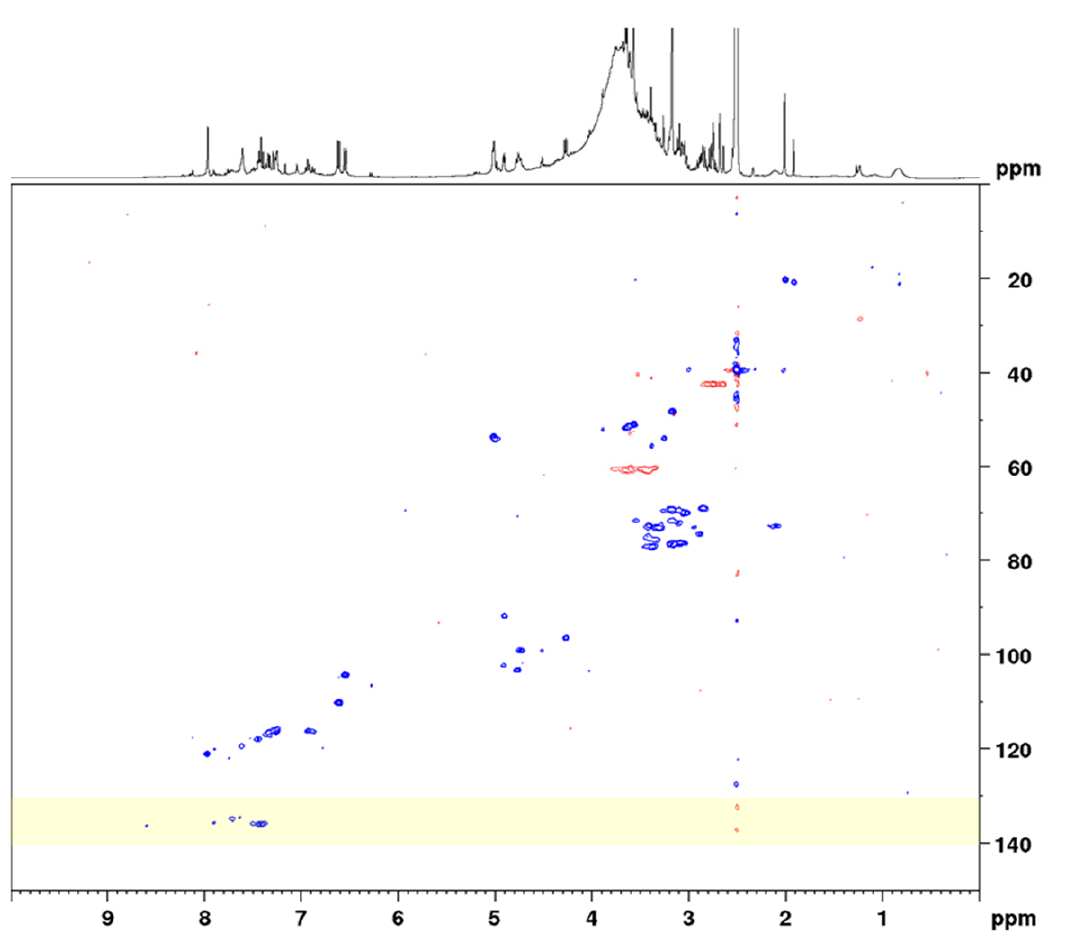
Figure 5. Complete spectral range HSQC diagram of senna solid-phase extract (1 g pods) in DMSO- d 6 with delays optimized for 163 Hz. The 13 C spectral range used for band-selective measurements is marked in yellow.